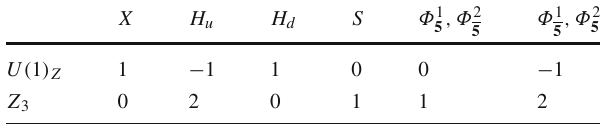
Table 5 Charge assignment in the DGSU